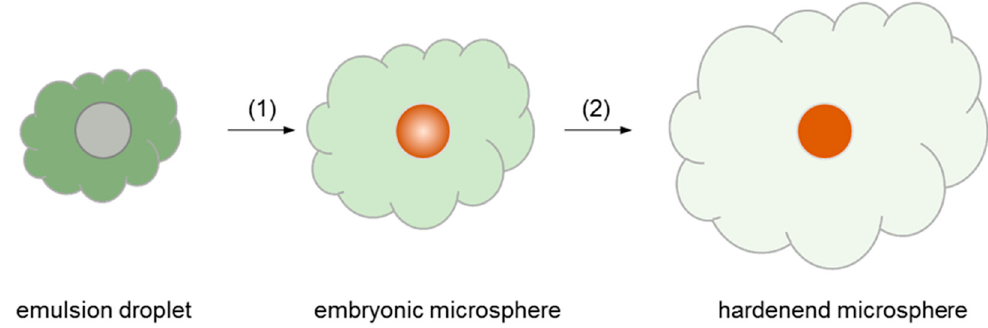
Figure 1. Pictorial representations of our essential microencapsulation approach. Step (1) is carried out to produce embryonic, semisolid microspheres. Step (2) stands for the primary solvent extraction process for microsphere hardening. The color gradient represents the difference in the aqueous ethyl formate concentration during microencapsulation. The fading intensity indicates that an aqueous ethyl formate concentration is being diluted, as the system is quenched with water.